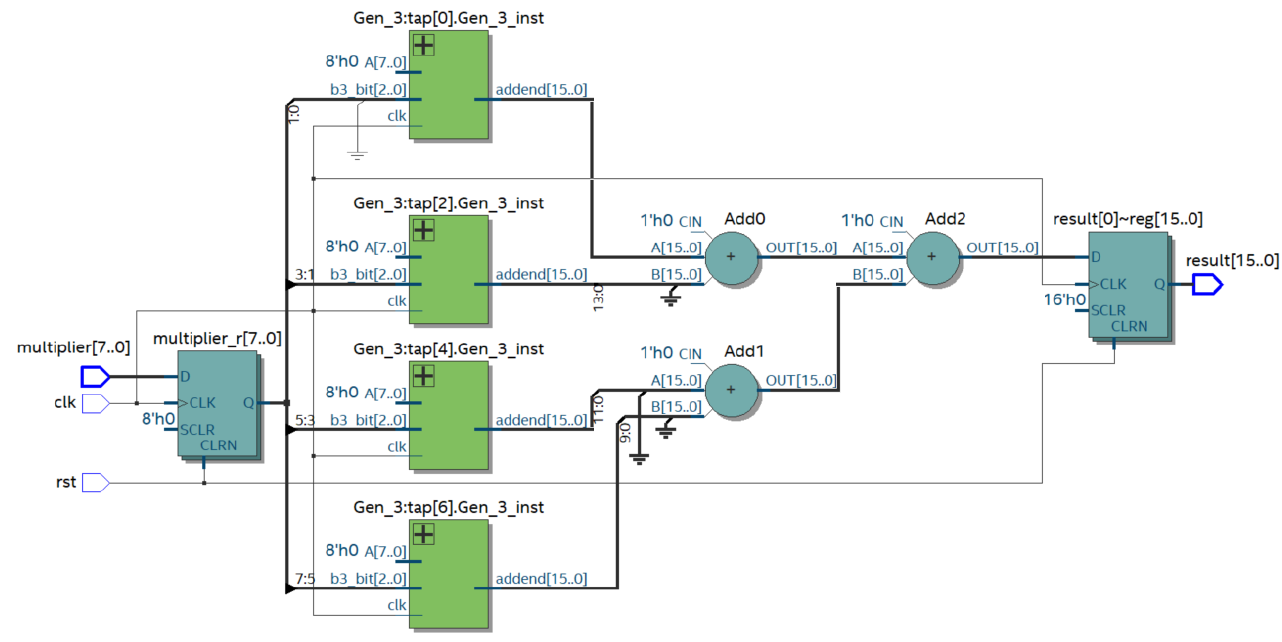
Figure 7. RTL of a modified Booth ’s algorithm implementing multiplication by a constant and synthesized by Quartus Prime for n = 8.